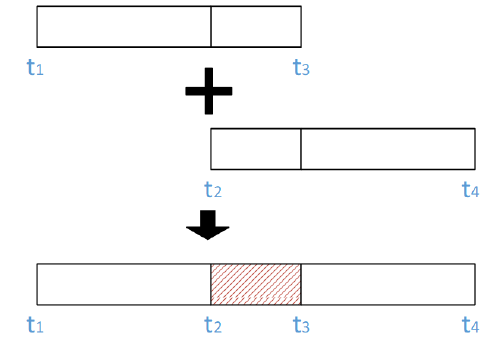
Fig. 3 Time-series data